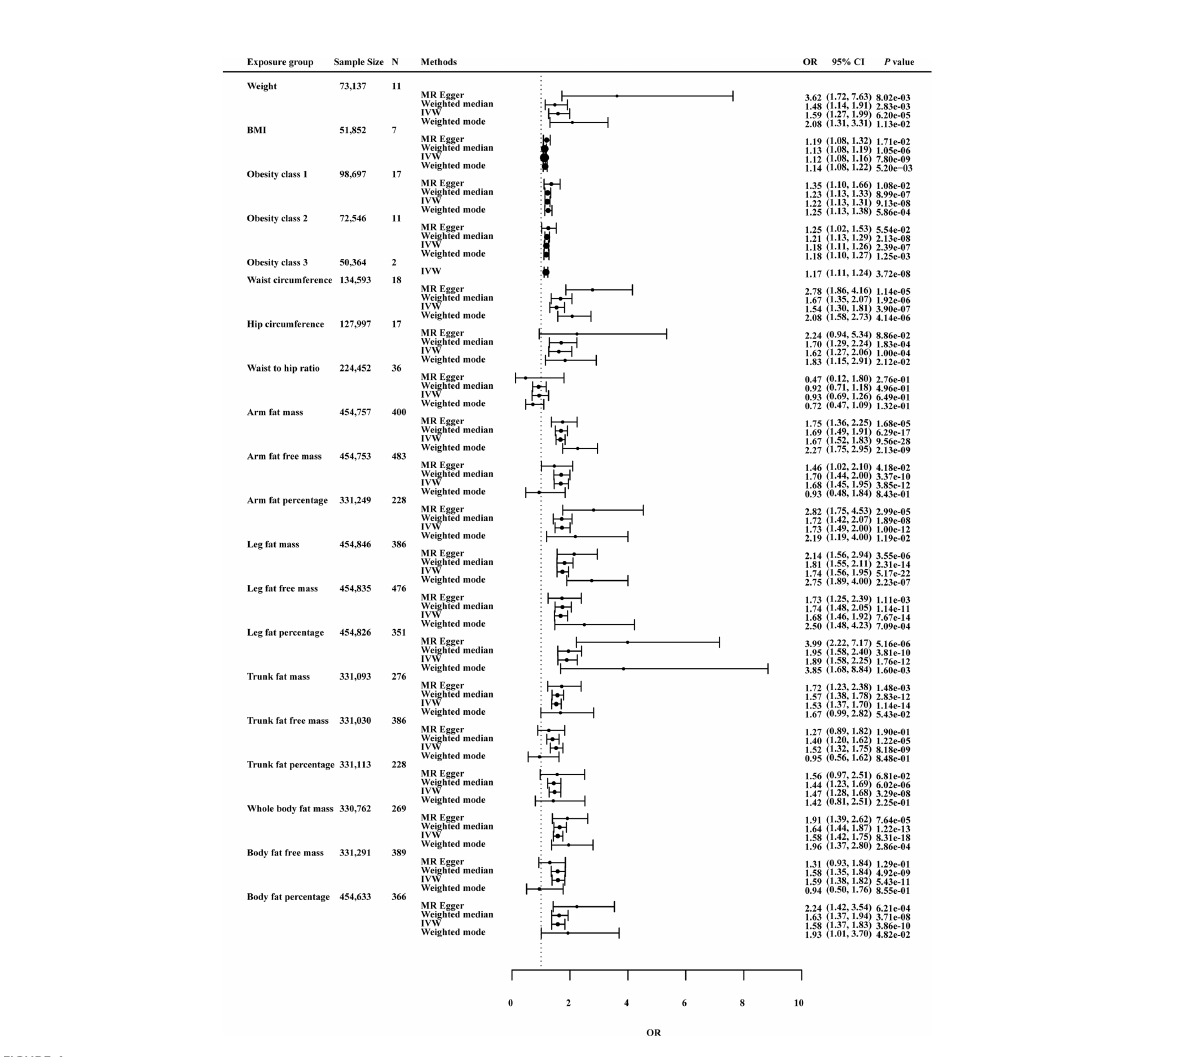
FIGURE 4 Effects of obesity-related exposures on hip OA. Results from univariable MR analyses showing the effects of genetic predicted obesity related anthropometric indicators and body compositions on hip OA with IVW, MR-Egger, weighted median, and weighted mode